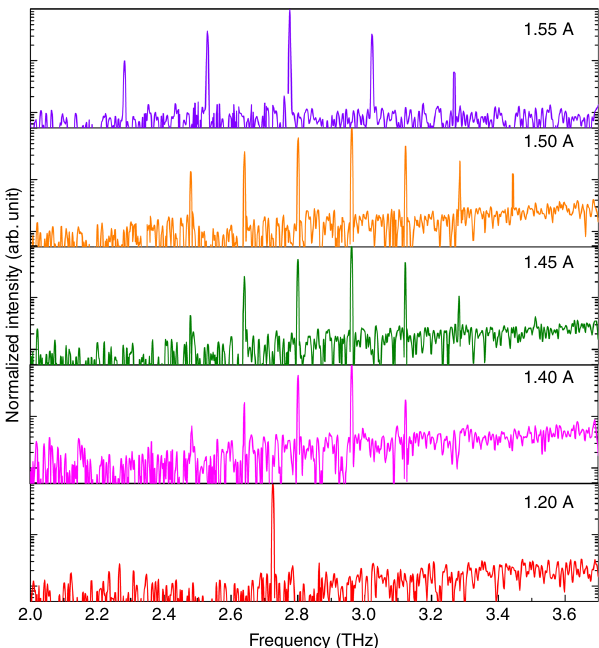
Fig. 5 On-chip generation of THz frequency comb from a mid-IR QCL. Lasing THz spectra of the DFB QCL comb evolving at different currents from 1.20 to 1.55 A at room temperature continuous wave